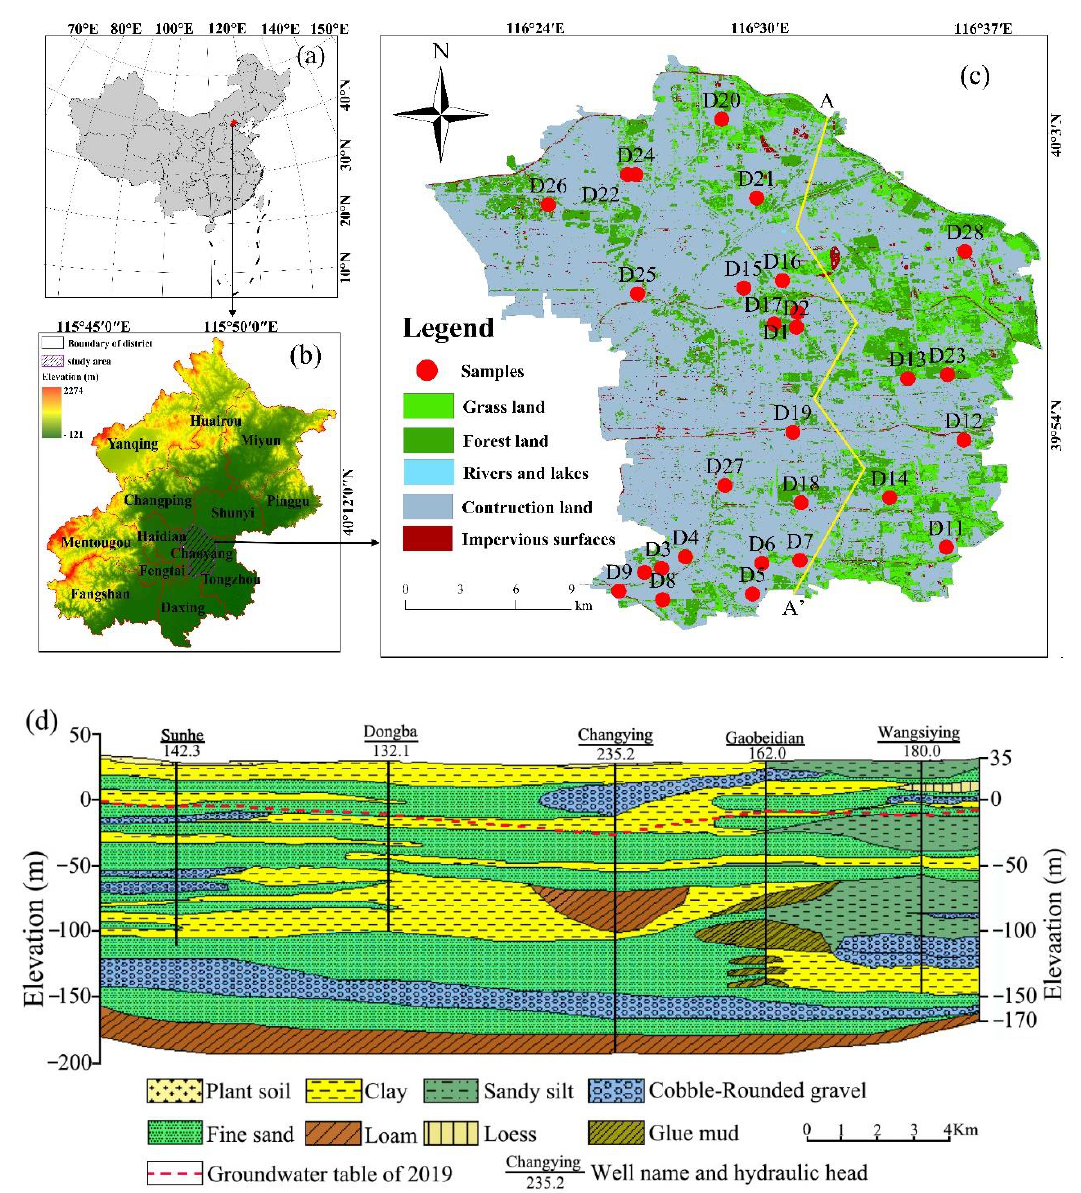
Figure 1. Maps showing ( a ) the location of Beijing in China. ( b ) the location of study area in Beijing. ( c ) the sampling locations of groundwater in study area combined with land use. ( d ) A- A’ hydrogeological profile in the study area.